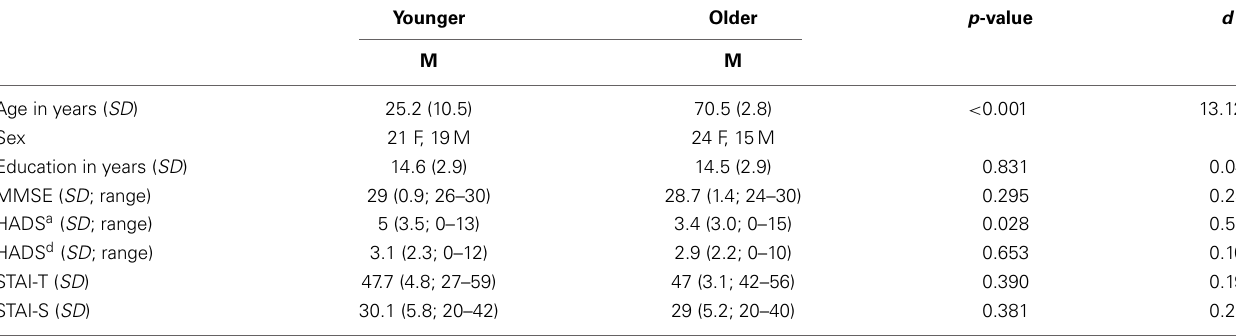
Table 1 | Participant characteristics by age group.